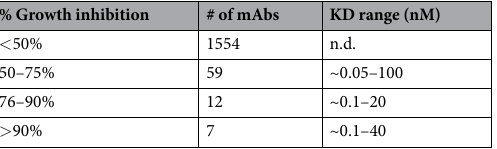
Table 1. Summary of functional properties of anti-BamA mAbs. Affinity values for a subset of the anti-BamA mAbs as determined by Wasatch. All inhibitory mAbs bind by ELISA to only E. coli BamA and not Entero or Kleb BamA.